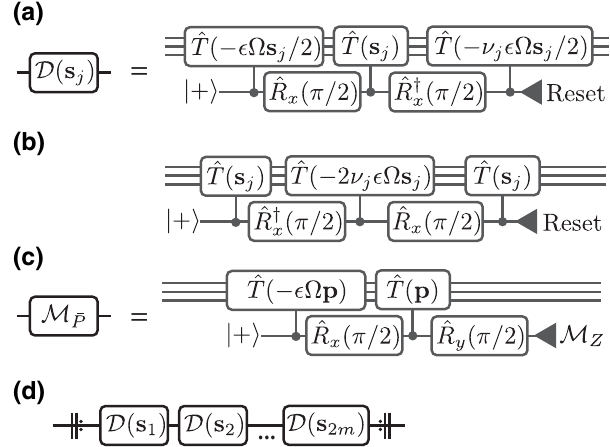
FIG. 3. Autonomous QEC circuits based on a qubit ancilla. The first three wires represent the ensemble of m modes, and the last wire corresponds to the two-level ancilla. (a) General- ized small-big-small protocol, which we represent at the logical level as applying an operation D ( s j ) . (b) Generalized big-small- big protocol. In both protocols, the sign of the “correction” controlled translations depends on the gauge, ν j = ( − 1 ) μ j . (c) Finite-energy Pauli operator measurement. (d) The full code space can be stabilized by cycling through the dissipation rounds for all generators { s j }